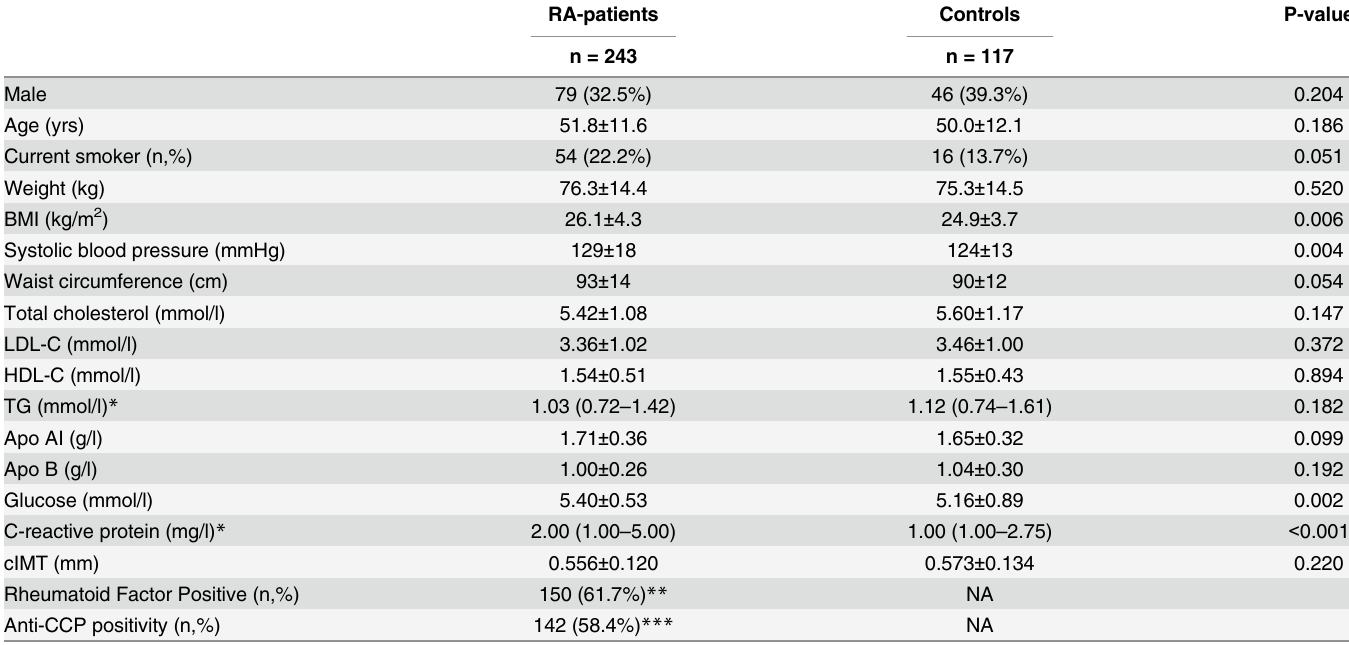
Table 1. General